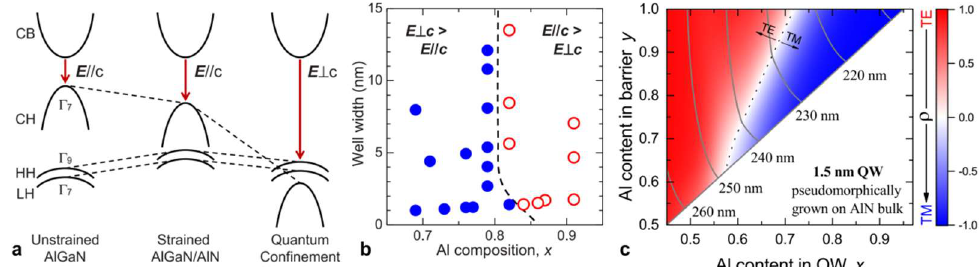
Figure 12. ( a ) Schematic energy band structures for unstrained AlGaN, strained AlGaN on AlN, and AlGaN/AlN QW near the Γ point with high Al content. CB denotes the conduction band. ( b ) Emission polarization mode as function of Al composition and well width [142]. ( c ) DOP of the emission from an AlGaN-based QW with 1.5 nm thickness pseudomorphically grown on AlN bulk calculated by k·p theory [143].